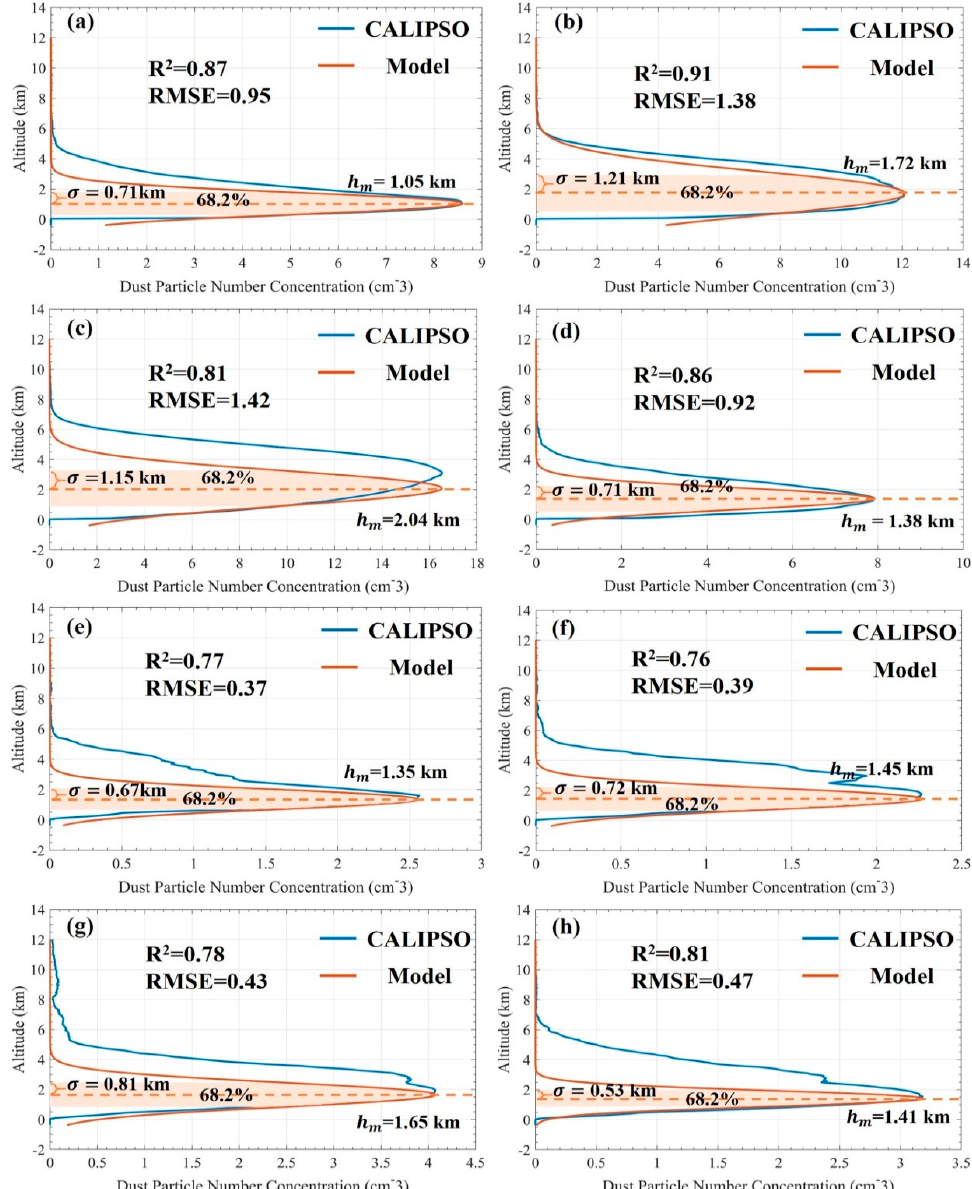
Figure 14. The comparisons of monthly mean vertical profile of dust and smoke particle number concentrations between model predictions and CALIPSO observations in 2016. ( a ) Dust aerosol in January; ( b ) dust aerosol in April; ( c ) dust aerosol in July; ( d ) dust aerosol in October; ( e ) smoke aerosol in January; ( f ) smoke aerosol in April; ( g ) smoke aerosol in July; ( h ) smoke aerosol in October. Besides the monthly products validations, we also validated the predicted daily vertical distributions of dust and smoke aerosols by comparing with the altitude of biomass burning emissions injection and dust aerosol derived from CAMS and IASI. Figure 15 showed the